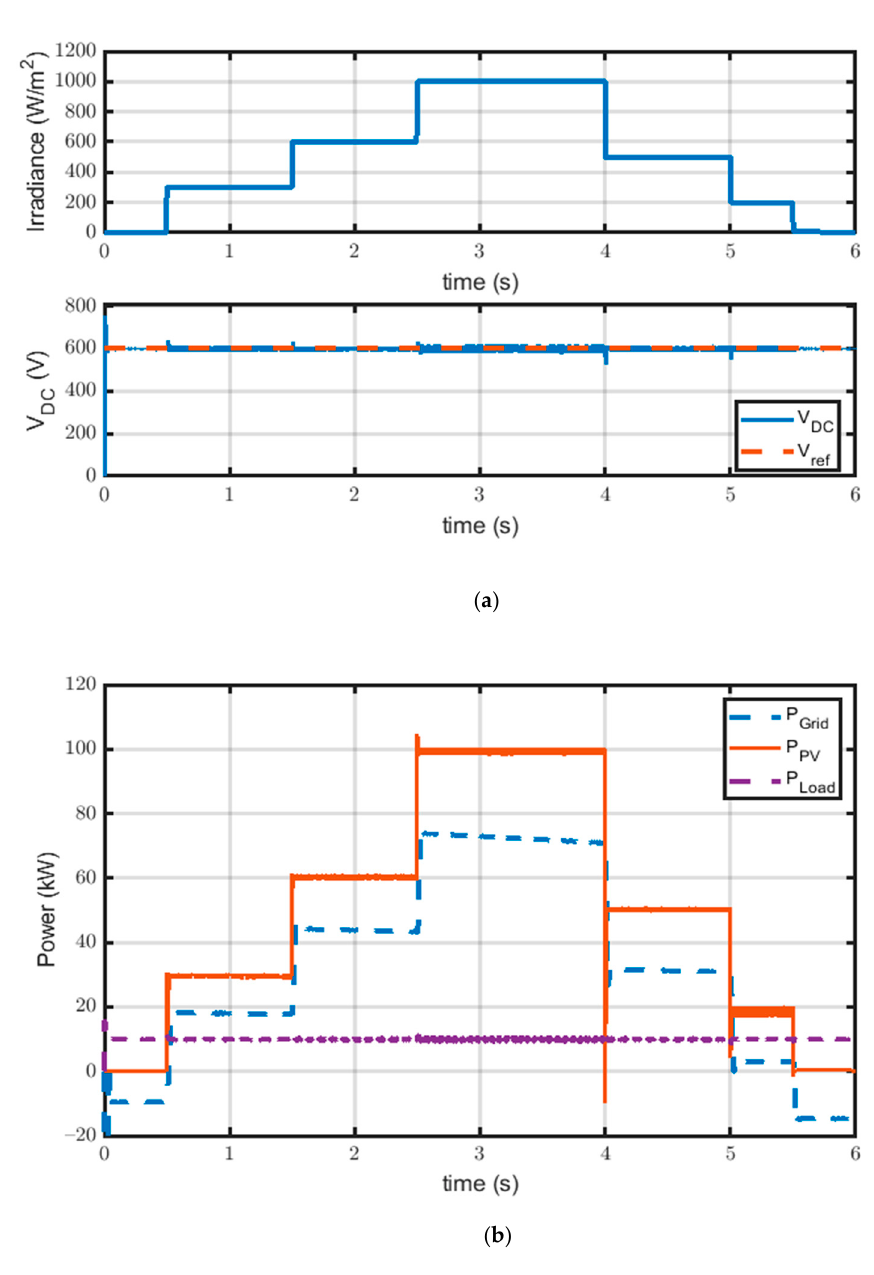
Figure 8. Grid-tied PV microgrid response; ( a ) Irradiation & DC voltage at load point, and ( b ) Power flow through DC microgrid.